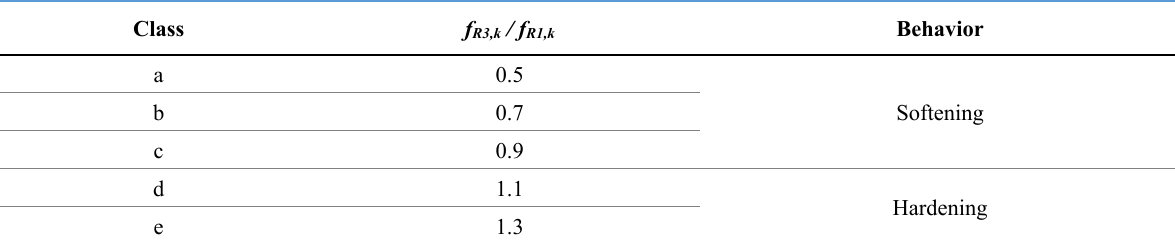
Table 7. Classification according to Model Code 10 [9]